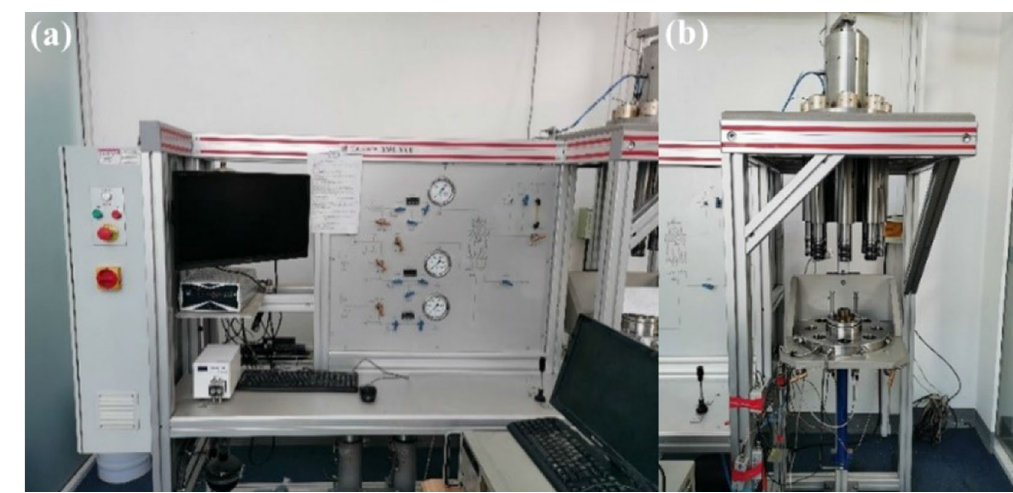
Figure 2. Stac 600–600 rock triaxial rheological test system. ( a ) Data acquisition system. ( b ) Loading